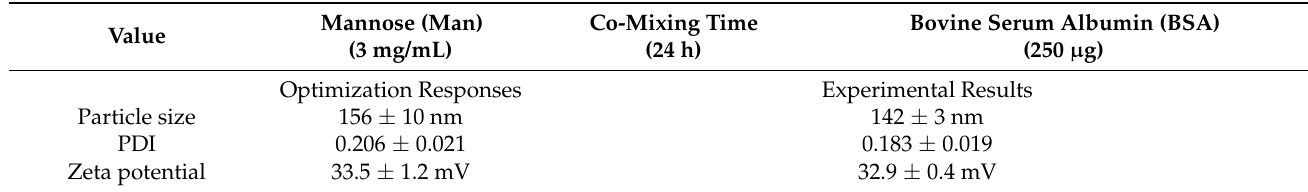
Table 2. Calculated optimization of Man-BSA-CS-NPs by the Minitab 10 software.